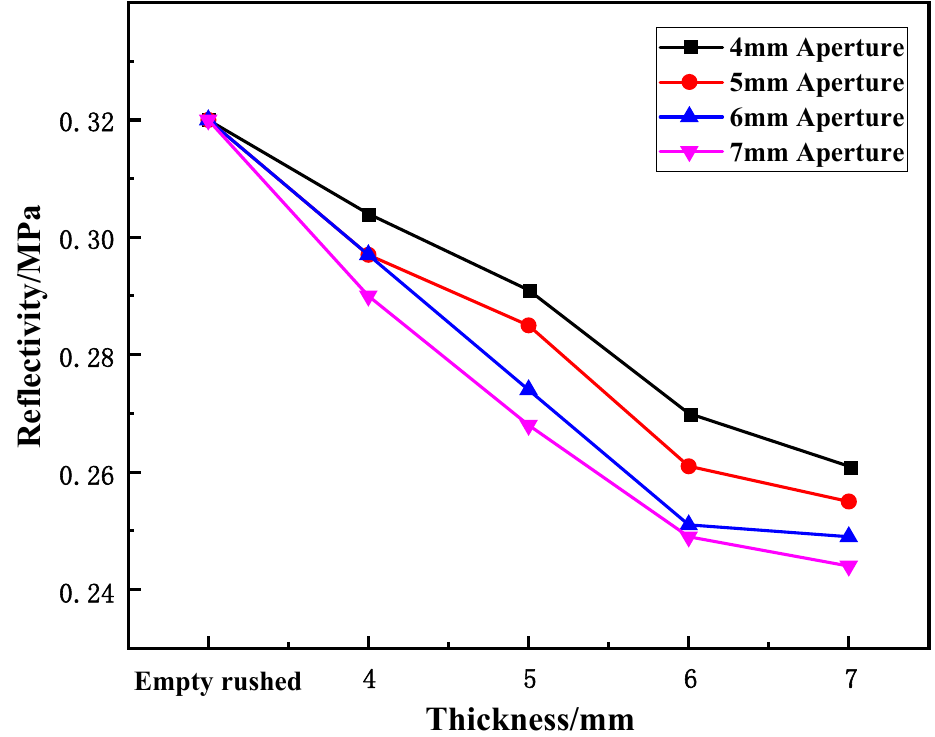
Figure 12. Variation trend of reflectivity with thickness of wave-absorbing metal plate. For four different thicknesses, the reflectivity of the wave-absorptive metal plate de- creased with increasing thickness. The decreasing trend starts to plateau when the thickness is 3 mm, indicating that the thickness has a critical value for the reduction in reflectivity. Before this value, a linear relationship exists between thickness and reflectivity, and beyond this value, increasing the thickness of the metal plate had no effect on